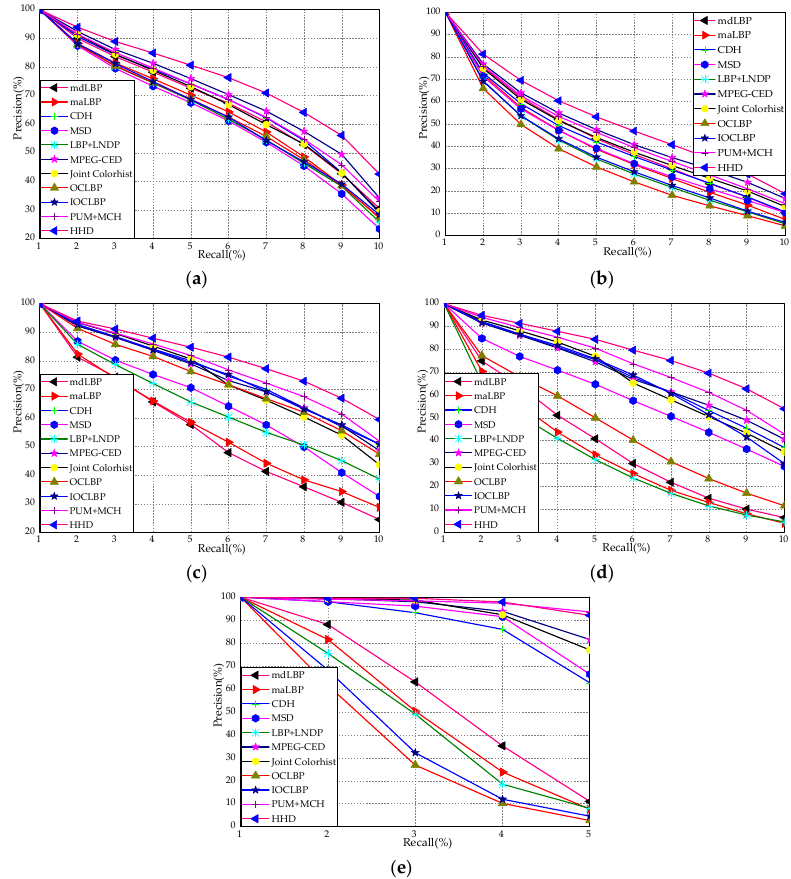
Figure 8. Precision–recall curve of different descriptors over five databases: ( a ) Outex-00013; ( b ) Outex-00014; ( c ) RSSCN7; ( d ) AID; and ( e ) ETHZ-53.